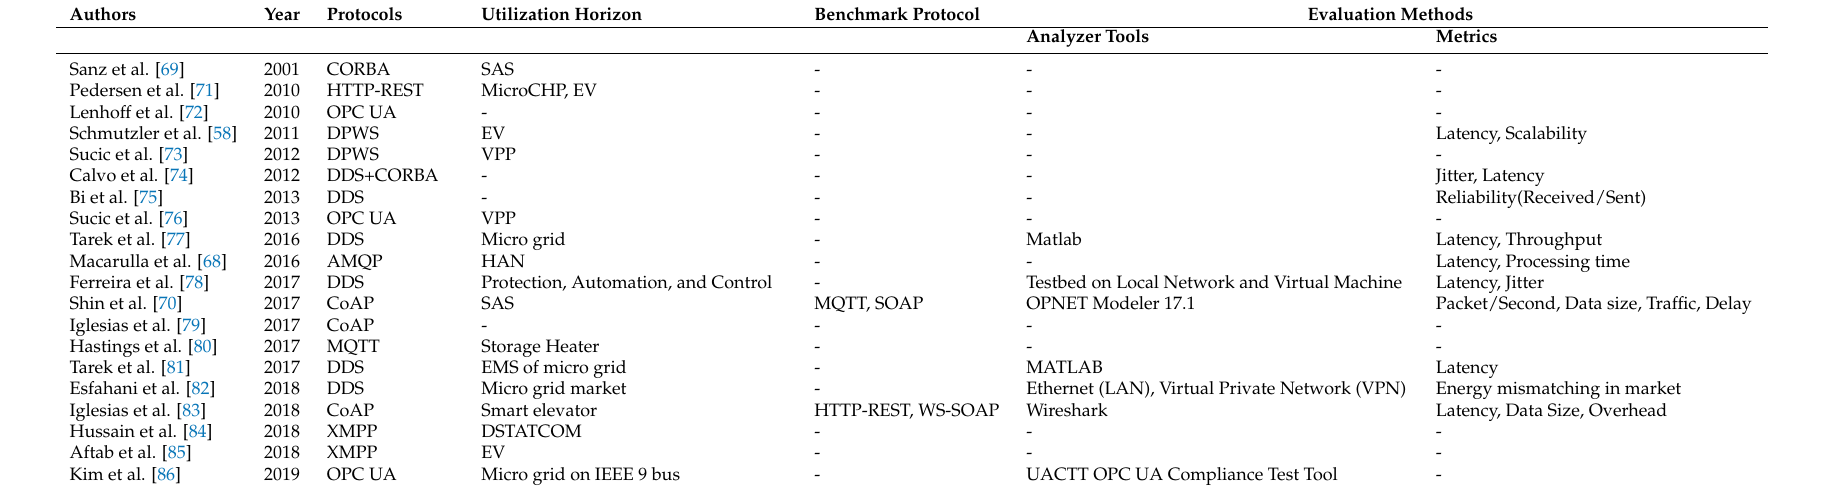
Table 5. Comparison of IoT protocols in the smart grid environment through